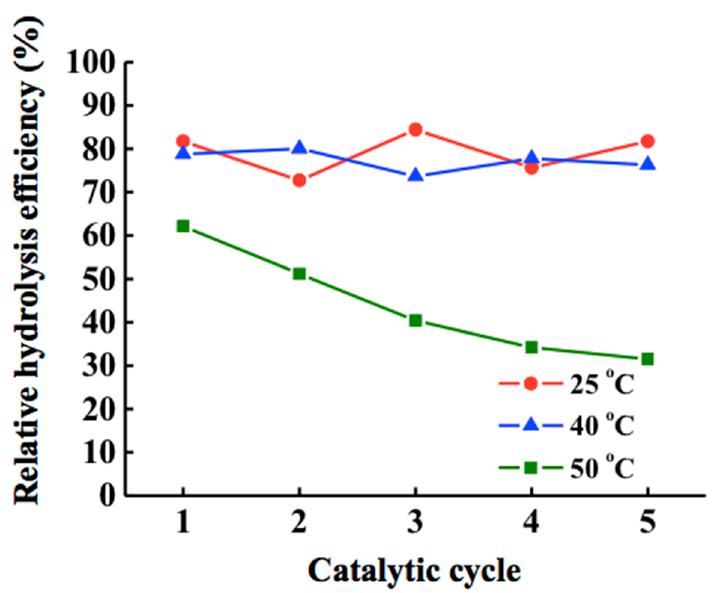
Figure 2. Comparison of the starch hydrolysis efficiency of fragmented α -amylase@UiO-66 at different reaction temperature.